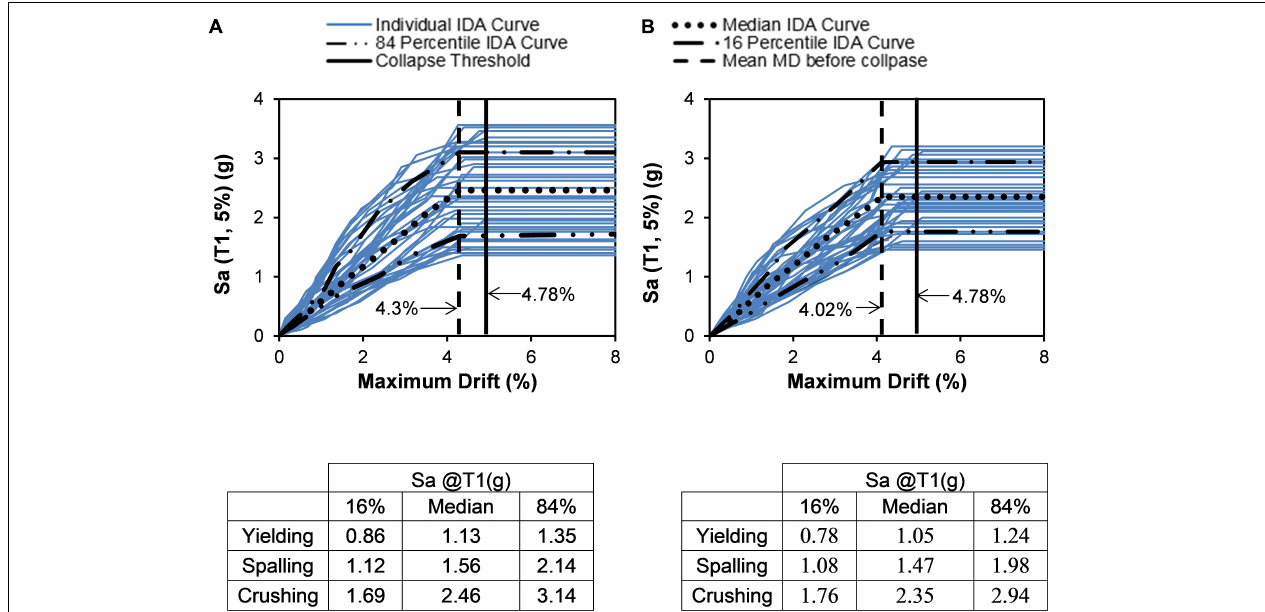
FIGURE 10 | IDA curves for maximum drift for reinforced concrete bridge bent with SMA at the bottom plastic hinge (SMA-B) (A) short duration motion (B) long duration motion.